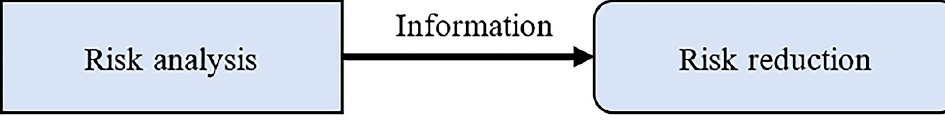
Figure 3. Interconnection between analysis and reduction of risk.